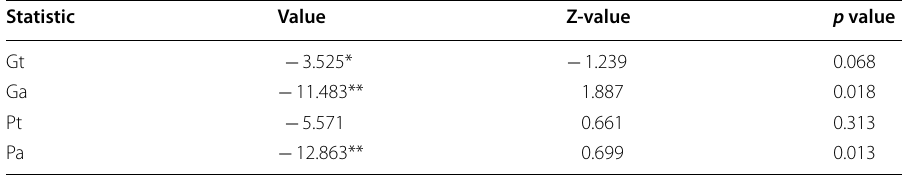
Table 8 Cointegration of Westerlund test outcomes